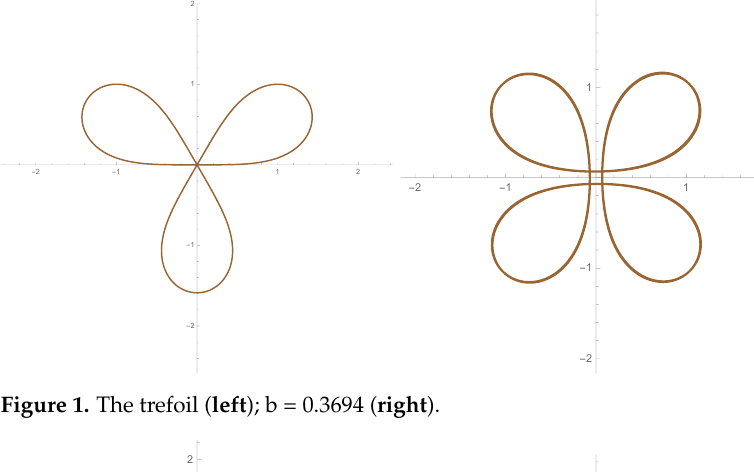
Figure 1. The trefoil ( left ); b = 0.3694 ( right ).